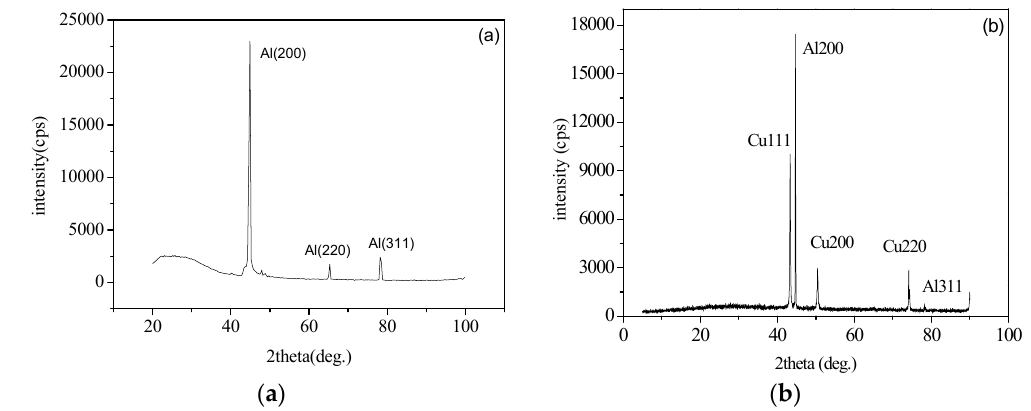
Figure 5. XRD analysis diagram of ( a ) anodic alumina film and ( b ) composite alumina film filled with copper nanowires.